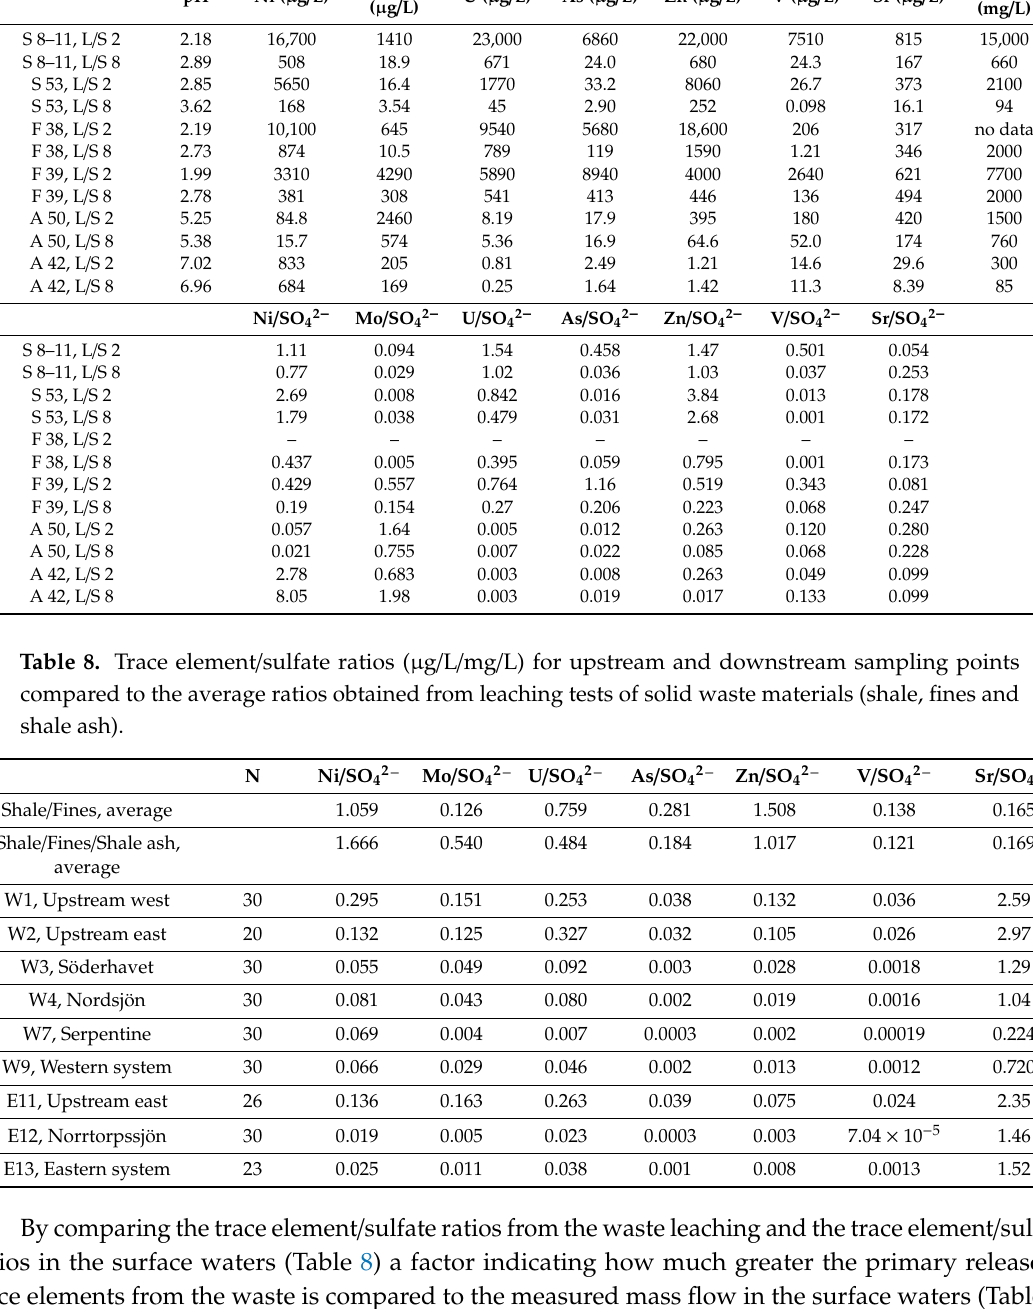
Table 7. Concentrations, as well as trace element / sulfate ratios ( µ g / L / mg / L) in leachates from shale (S), fines (F) and shale ash (A) (leached in deionized water). Mo U ( µ g / L) pH Ni ( µ g / L) ( µ g / L)